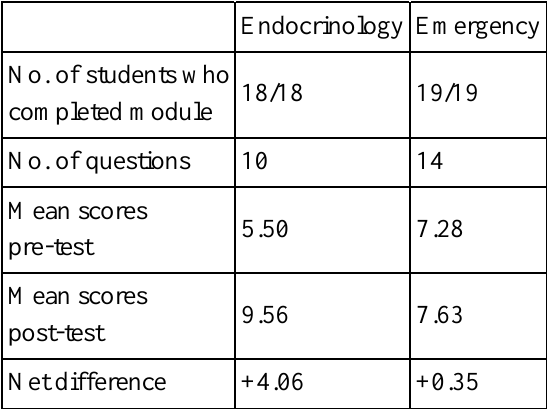
HSUM SMS Quiz Results (Adapted from Ramos, 2008, p.